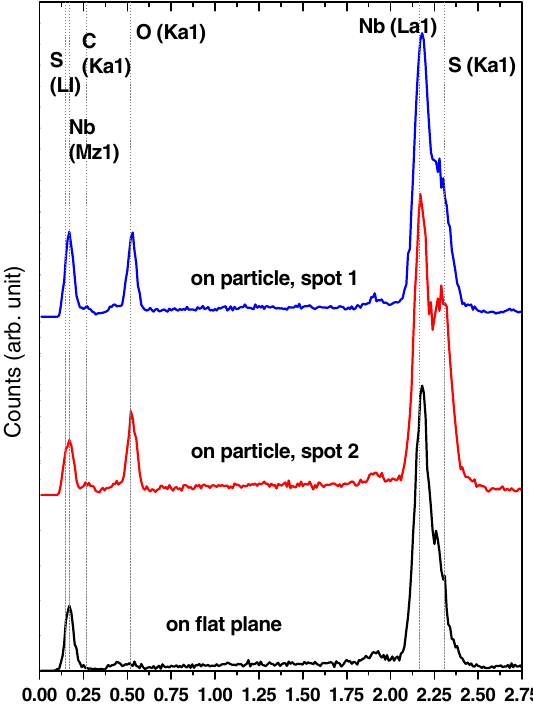
FIG. 11. EDX spectra (scaled) from two spots on a granule (Fig. 10) and from the off-granule flat plane (50 um away from the granule). Sulfur is enriched on spot 2 (red curve); the oxygen to niobium ratio is much higher on the granule than that of a normal EP’ed surface (black curve).